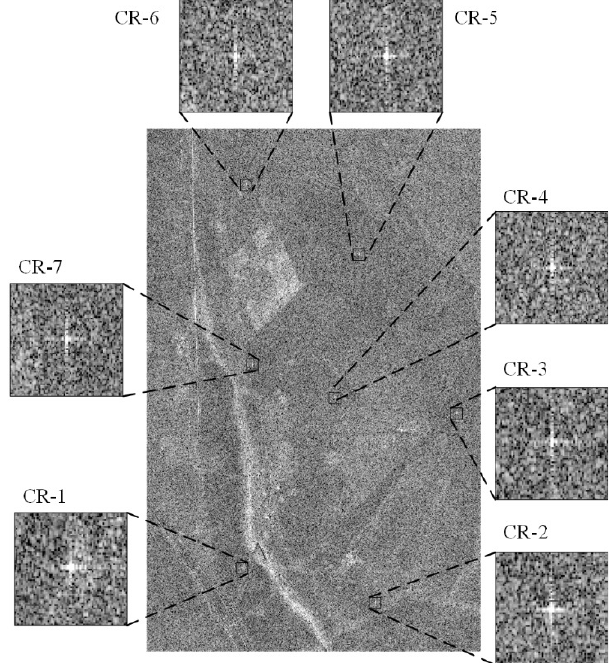
Figure 3. Distribution of automatic CRs of UFS mode images in the experimental area on 12 May.